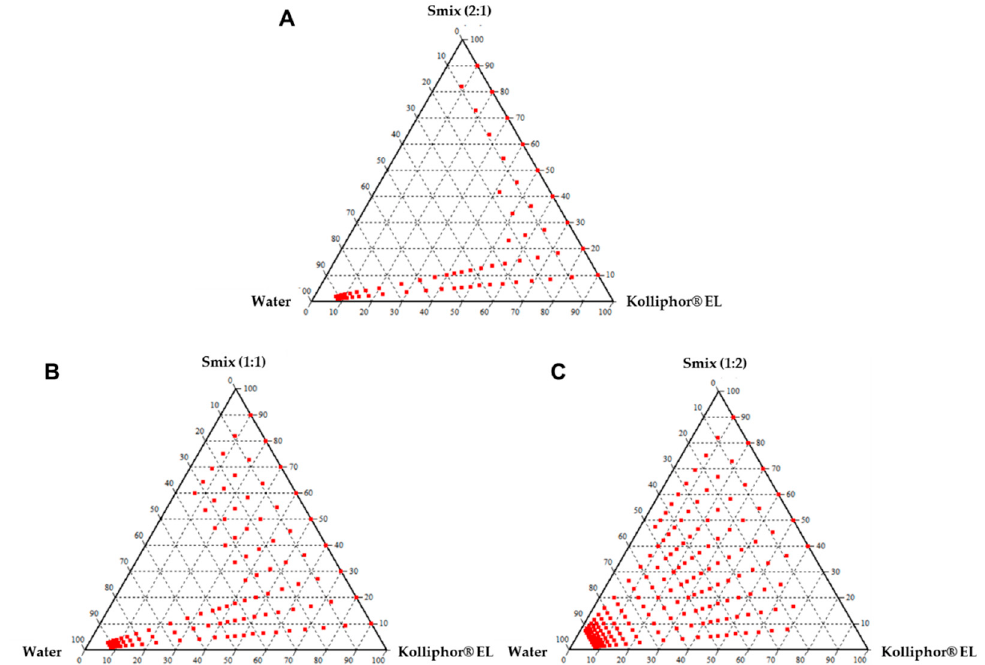
Figure 2. Pseudoternary phase diagrams containing Kolliphor ® EL, Tween 80:PEG 400 (S mix ), and